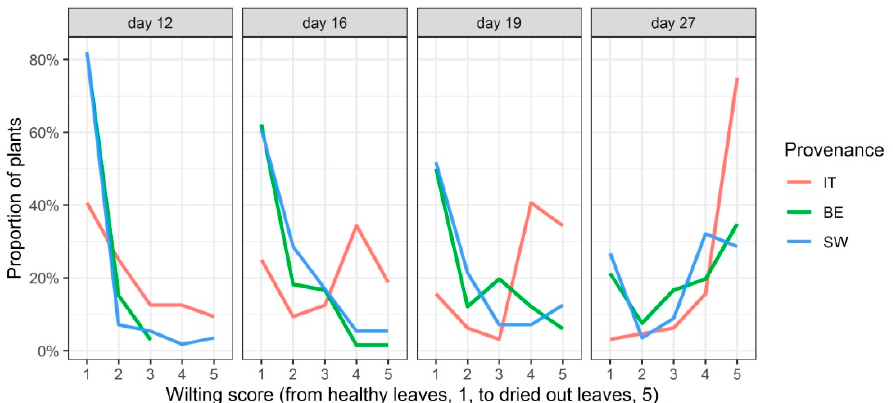
Figure 7. Leaf wilting scores during the water withholding treatment, observed on the 12th, the 16th, the 19th and the 27th day of the treatment. IT: Italian provenance, BE: Belgian provenance, SW: Swedish provenance.